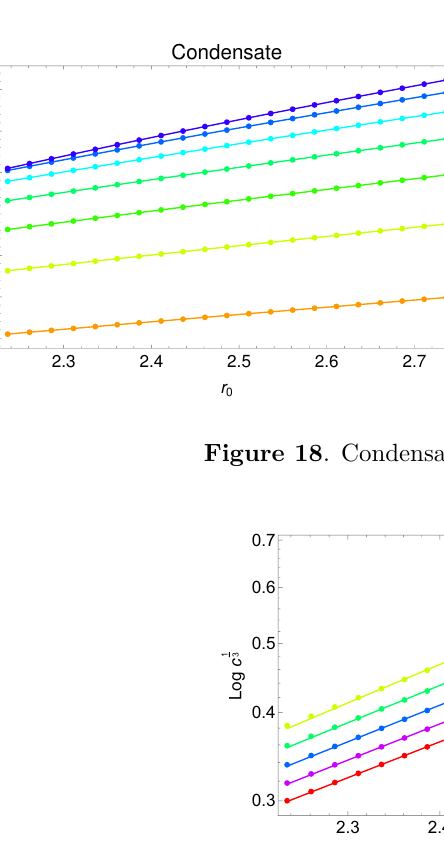
Figure 17 . Condensate for cutoff branes in the Black hole background.